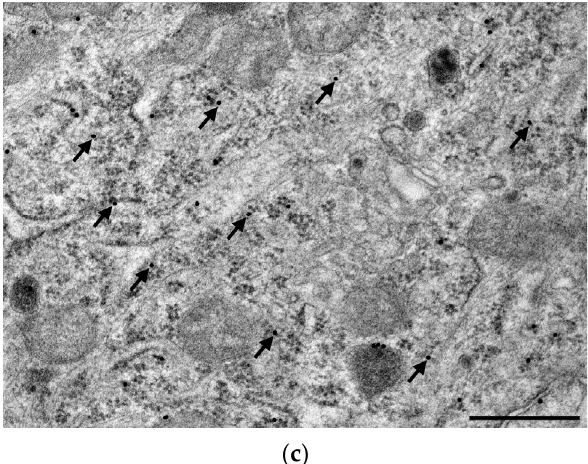
Figure 6. Representative electron micrographs of myenteric neuronal perikaryon and ganglionic neuropil from the ileum of a control rat after TLR4 post-embedding immunohistochemistry. The number of TLR4 labelling gold particles was higher in neuronal perikaryon ( a , c ) than in myenteric neuropil ( a , b ). Arrows—18 nm gold particles labelling TLR4, scale bars: 500 nm.